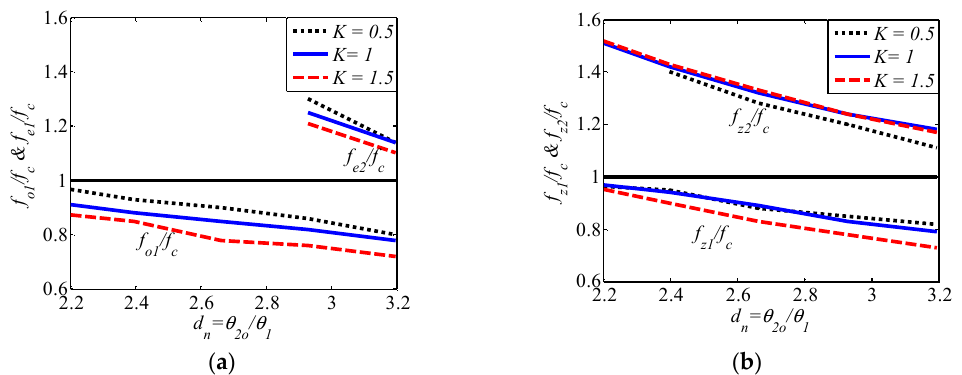
Figure 4. ( a ) Even- and odd-mode resonant frequencies vs. length ratio ‘ d n ’, ( b ) TZ’s frequencies vs. length ratio ‘ d n ’.